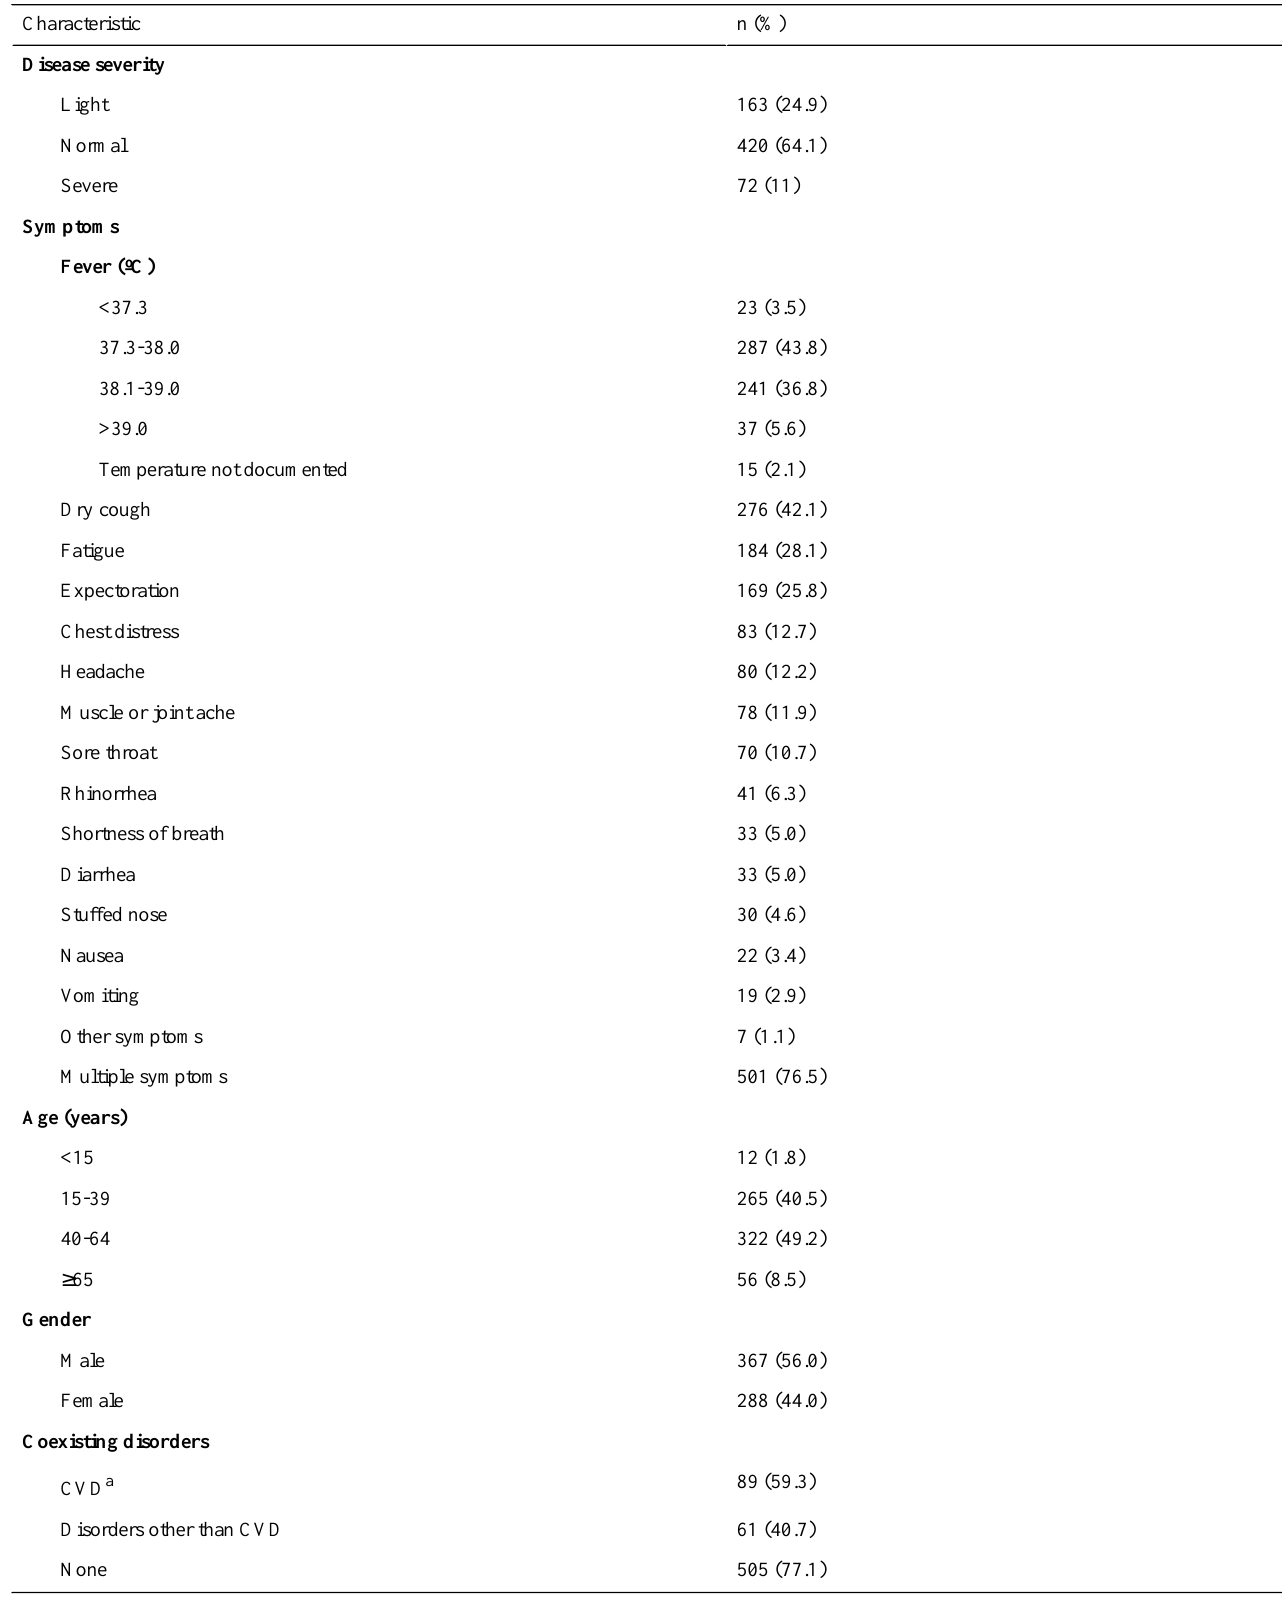
Table 1. Documented symptoms and general clinical characteristics of 655 patients with COVID-19